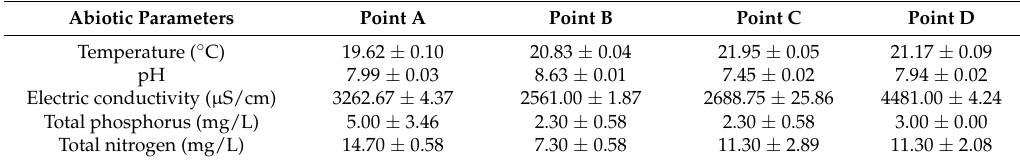
Table 2. Longitudinal profile of physicochemical variables through the semi-natural ponds system.